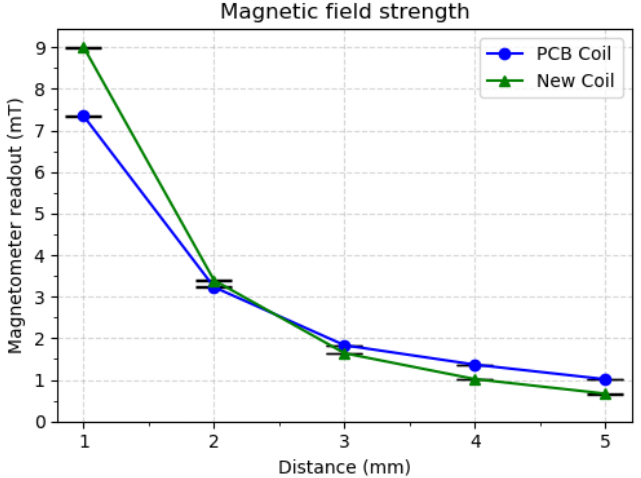
Figure 3. Magnetic field strength results. Values from the previous PCB coil and new coil present similar